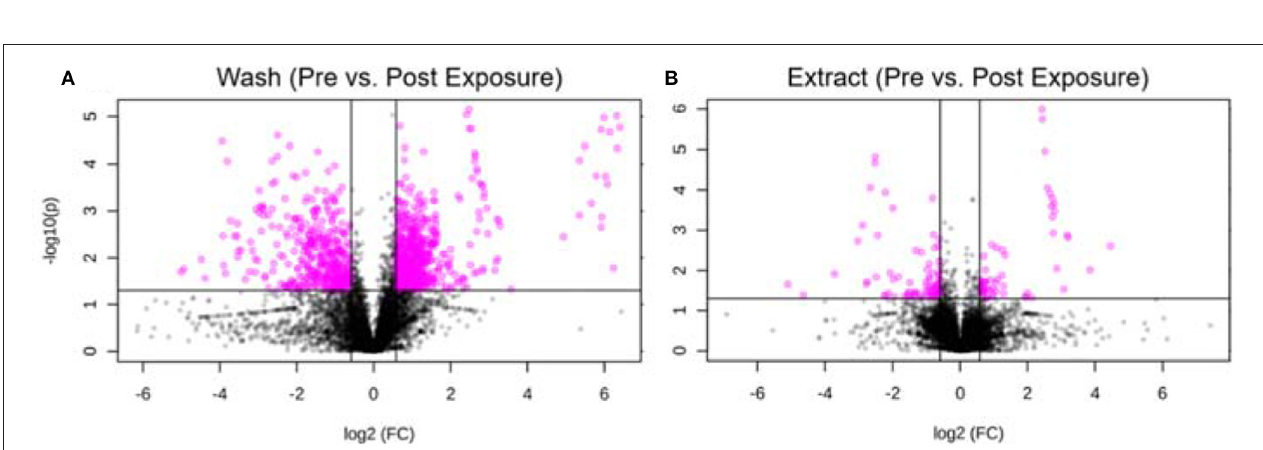
FIGURE 6 | Volcano plot of significantly changed metabolic features. (A) Hair wash; (B) hair extract. The pink dots represent metabolic features that were significantly changed during the 2 days exposure. The black dots are features that have no significant difference before and after the 2 days exposure. The p -value threshold is 0.05 and the fold change threshold is > 1.5 or < 0.67. Six hundred and forty-five and eighty-nine metabolic features were significantly changed in the hair wash and hair extract solutions, respectively.